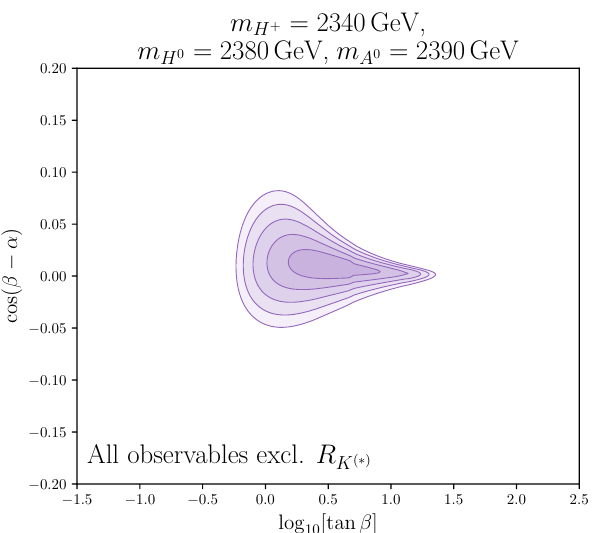
Figure 15. Contour plot of the allowed 2HDM-II parameter space in the (tan β − cos( β − α )) plane obtained by combining all observables excluding R the best fit point from table 2. The contours indicate the allowed parameter space at 1 , 2 , 3 , 4 , 5 σ confidence level going from darker to lighter.